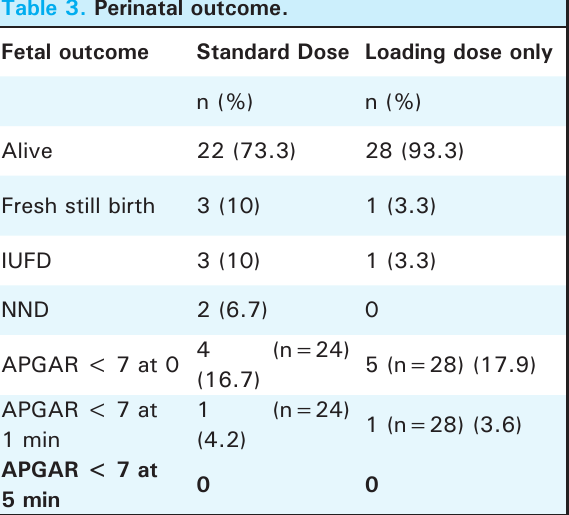
Table 3. Perinatal outcome. Fetal